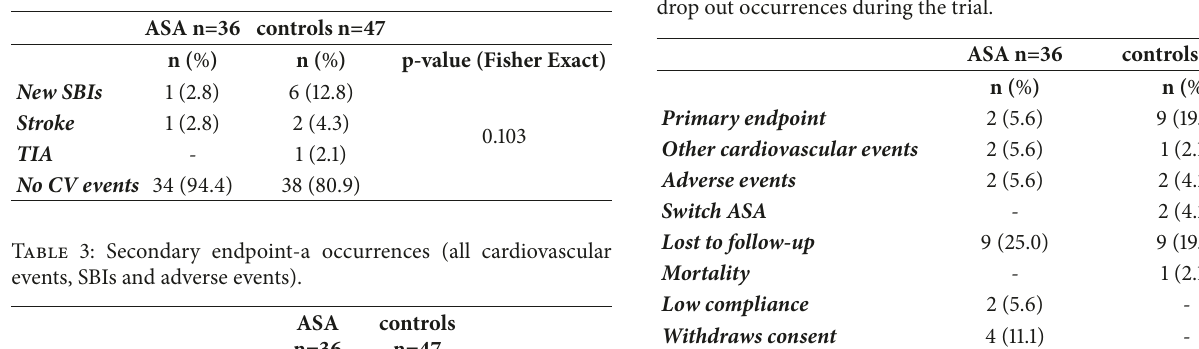
Table 2: Primary endpoint occurrences.